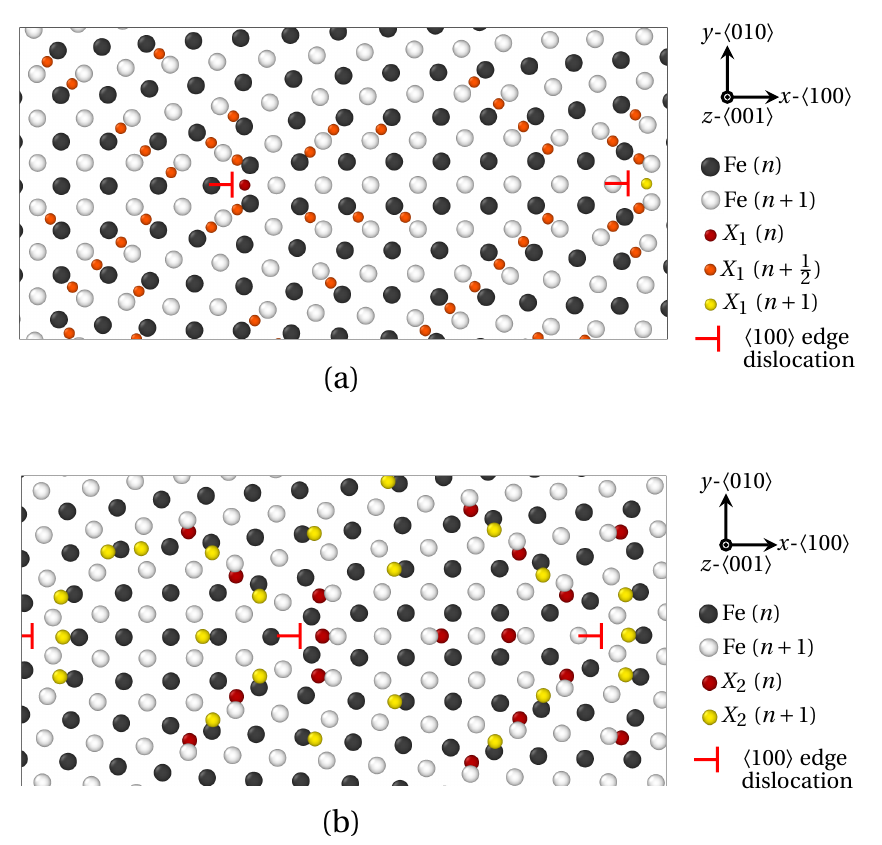
Figure 4. Solute atoms segregation at (cid:104) 100 (cid:105) symmetric tilt LAGBs consisting of a wall of (cid:104) 100 (cid:105) edge dislocations (red (cid:96) marks), as provided by QA simulations ( t = 400). ( a ) X 1 (small) atoms segregation for a misorientation angle θ = 7.15 ◦ . ( b ) X 2 (larger) atoms for θ = 9.53 ◦ . Visualization via OVITO [48] after projection on the ( 100 ) plane. Black and white spheres correspond to Fe atoms in two successive ( 100 ) planes ( n and n + 1), while red, orange and yellow spheres correspond to solute (X) atoms in three successive ( 100 ) planes ( n , n + 1 and n + 1). The size of atoms follows the ordering of solute 2 atoms radius ( R ( X 1 ) < R ( X 2 ) < R ( X 3 )